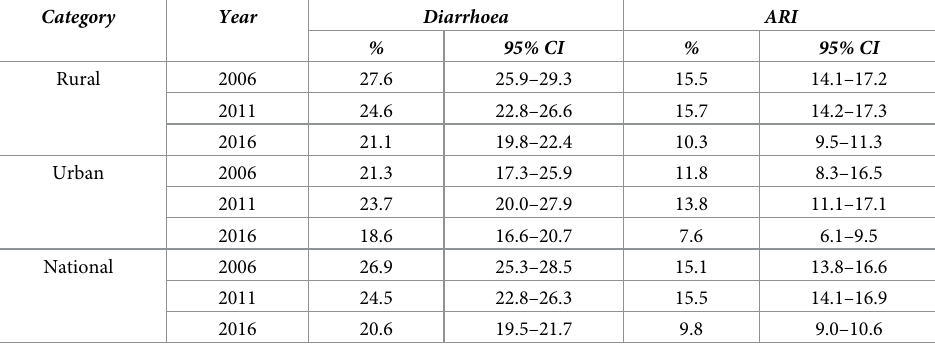
Table 2. Trends in the prevalence of ARI and diarrhoea among under-5 of age